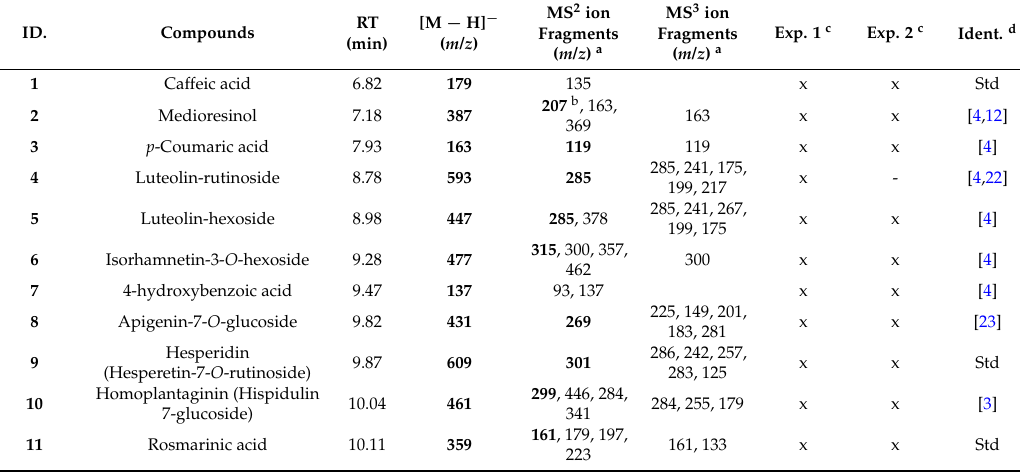
Table 1. (Poly)phenolic compounds in rosemary extract identified by ultra-high performance liquid chromatography-mass spectrometry (UHPLC-MS n ) in negative ionization mode under different mass spectrometry (MS)